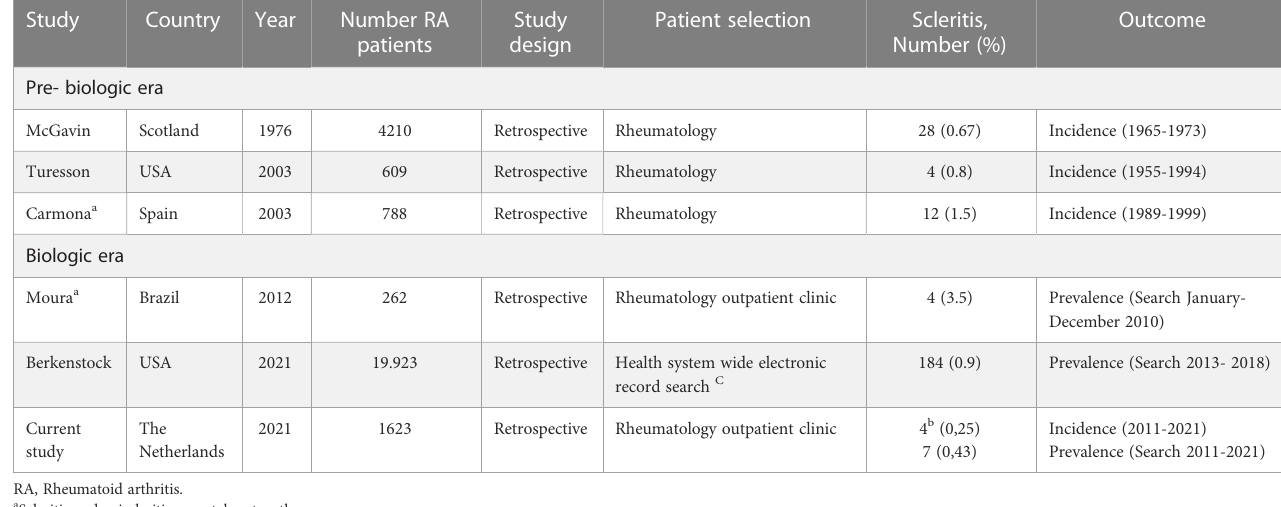
TABLE 1 Incidence or prevalence of scleritis within rheumatoid arthritis cohorts over time.